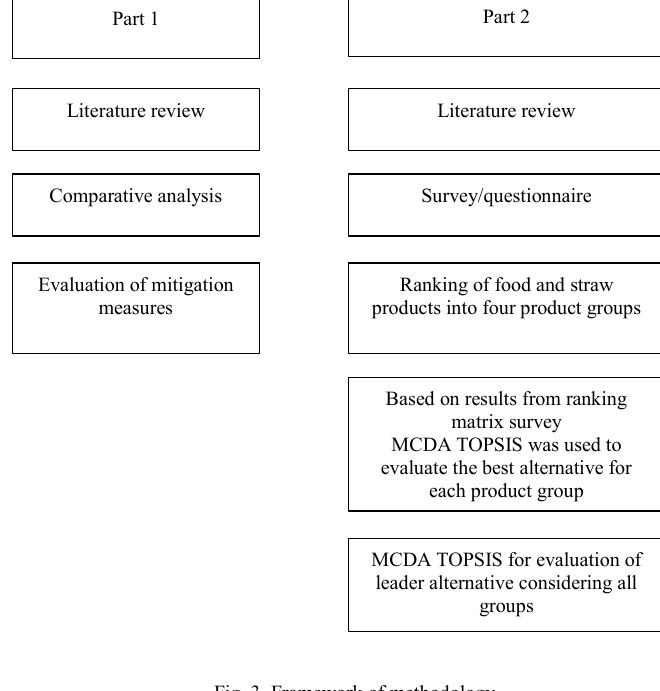
Fig. 3. Framework of